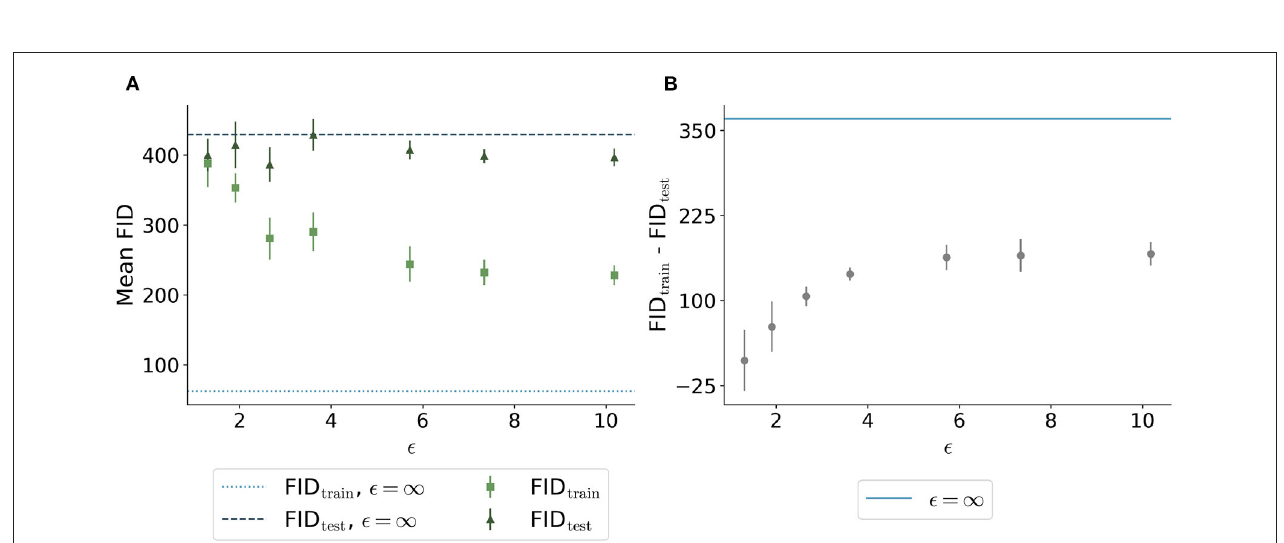
FIGURE 6 | Comparison of Fréchet Inception Distance (FID) between the synthetic images with different ǫ values and both the real training data (light green squares and light blue dotted line) and the real test data (dark green triangles and dark blue dashed line). (A) shows the absolute values for the 5 runs per ǫ whereas (B) shows the difference between the distances from synthetic to training and synthetic to test. The higher the value of ǫ , the closer the images are to the training set. The distance to the test set remains stable for different ǫ values. The difference shown in (B) is the highest for the model trained without differential privacy.